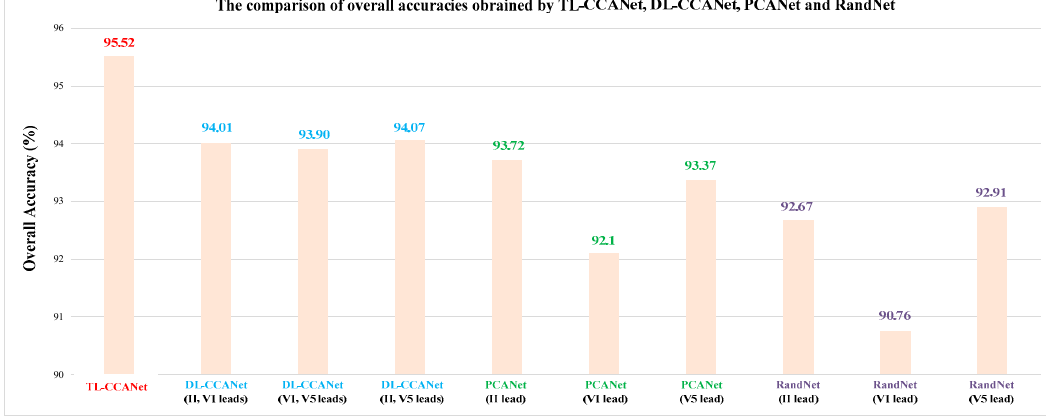
Figure 7. The comparison of the ECG classification performances across 10 folds using TL-CCANet, DL-CCANet, PCANet, and RandNet on INCART database.